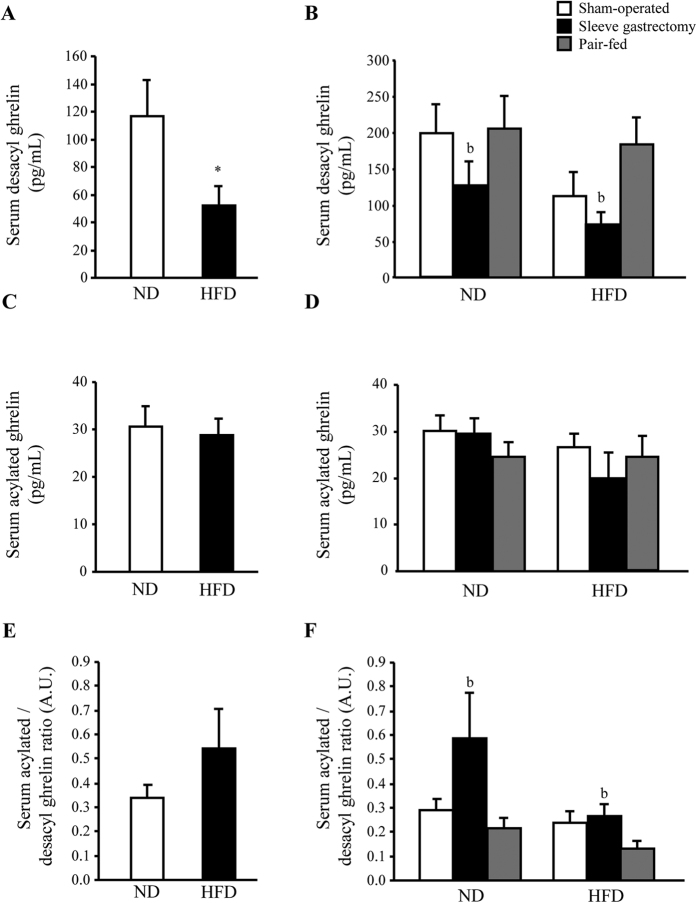
Effect of sleeve gastrectomy on circulating ghrelin isoforms.Bar graphs illustrate the impact of obesity and sleeve gastrectomy-induced weight loss on serum desacyl (A,B) and acylated (C,D) ghrelin levels as well as the acylated/desacyl ghrelin ratio (E,F). Differences were analyzed by Student’s t test or two-way ANOVA, where appropriate. *P < 0.05 vs lean control ND; bP < 0.05 effect of surgery.